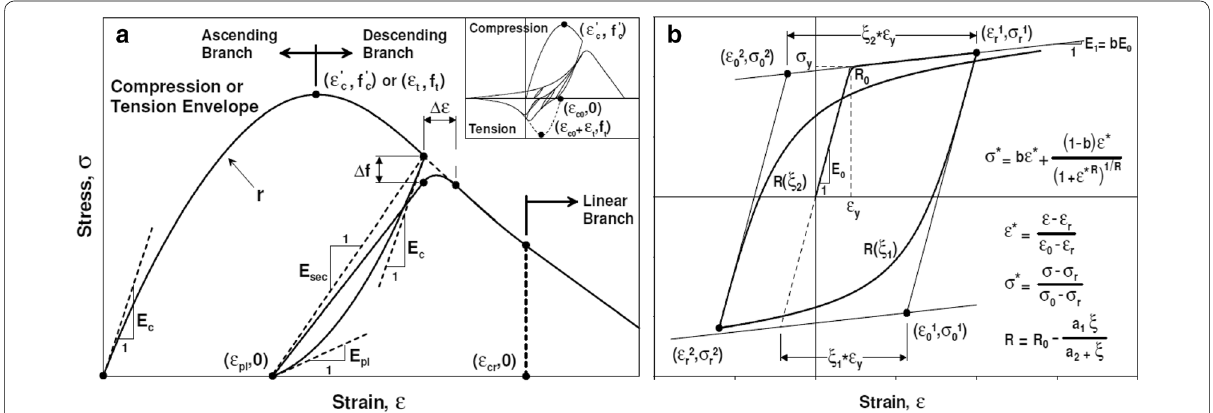
Fig. 2 Material constitutive models: a concrete (Chang and Mander 1994), b reinforcing steel (Menegotto and Pinto